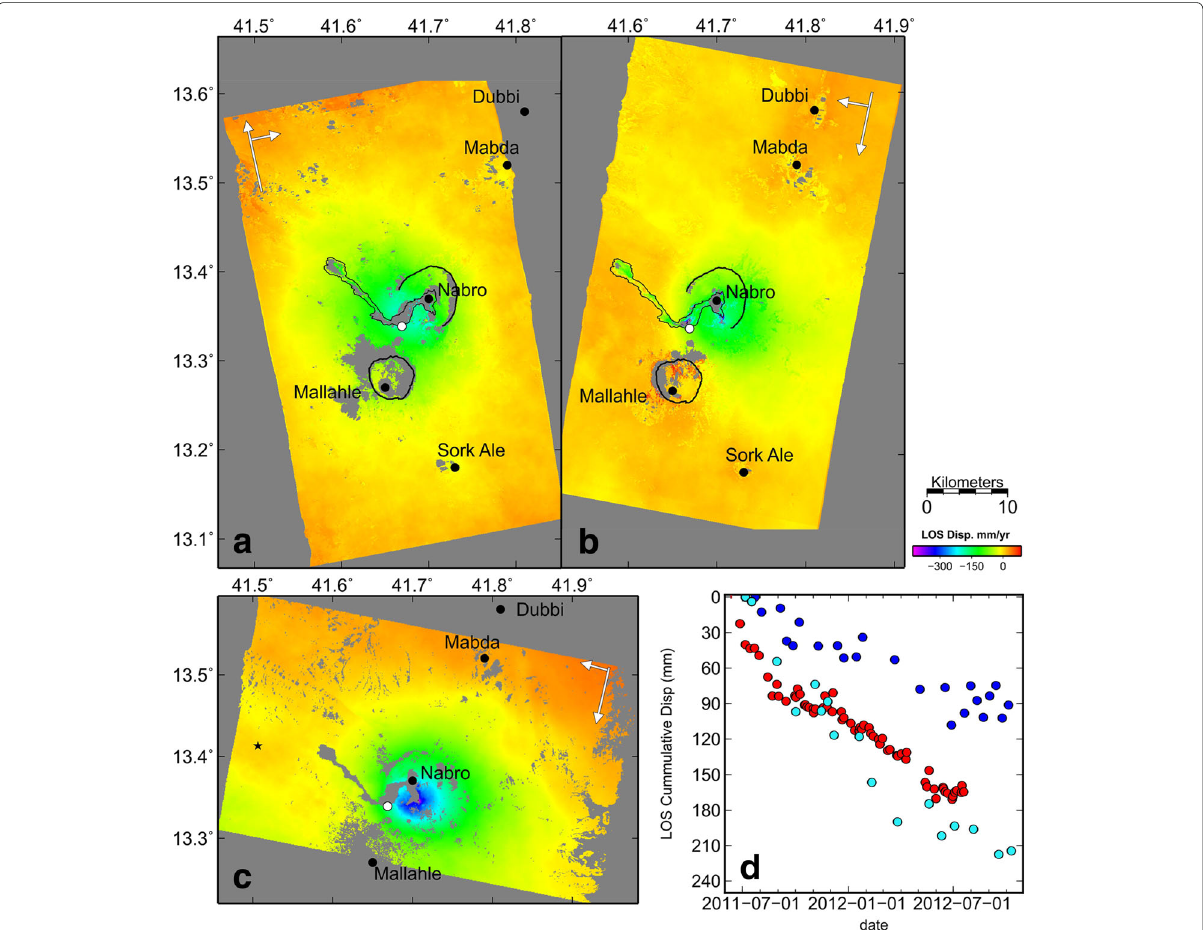
Fig. 3 InSAR-derived ratemaps and time series of displacement. a Ratemap of LOS displacement for the ascending TSX data set. b Ratemap of LOS displacement for the descending TSX data. c CSK ratemap of LOS displacement. d Time series of LOS displacement for TSX ascending (light blue), TSX descending (blue) and CSK (red), for the pixel highlighted with a white dot on the ratemaps. Positive values represent increases in range change. The CSK data is relative to the reference pixel (black star); the TSX is relative to an image average. CSK and TSX data sets are corrected for atmosphere using ERA-I weather model outputs with a small spatio-temporal filter applied